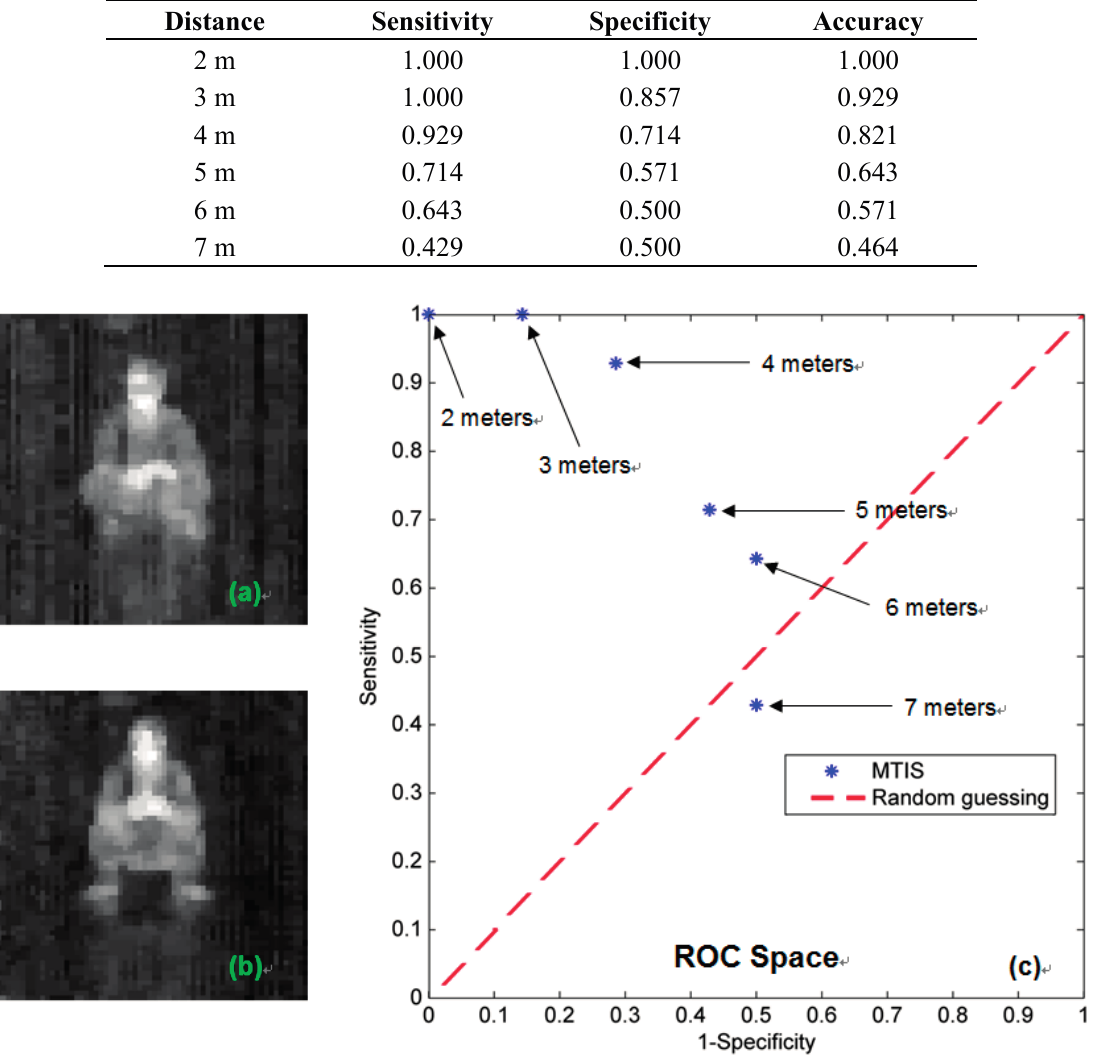
Figure 7. The recognition experiments of MTIS. ( a ) Sample pattern of the sitting position; ( b ) sample pattern of the crouched position; and ( c ) the receiver operating characteristic (ROC) space